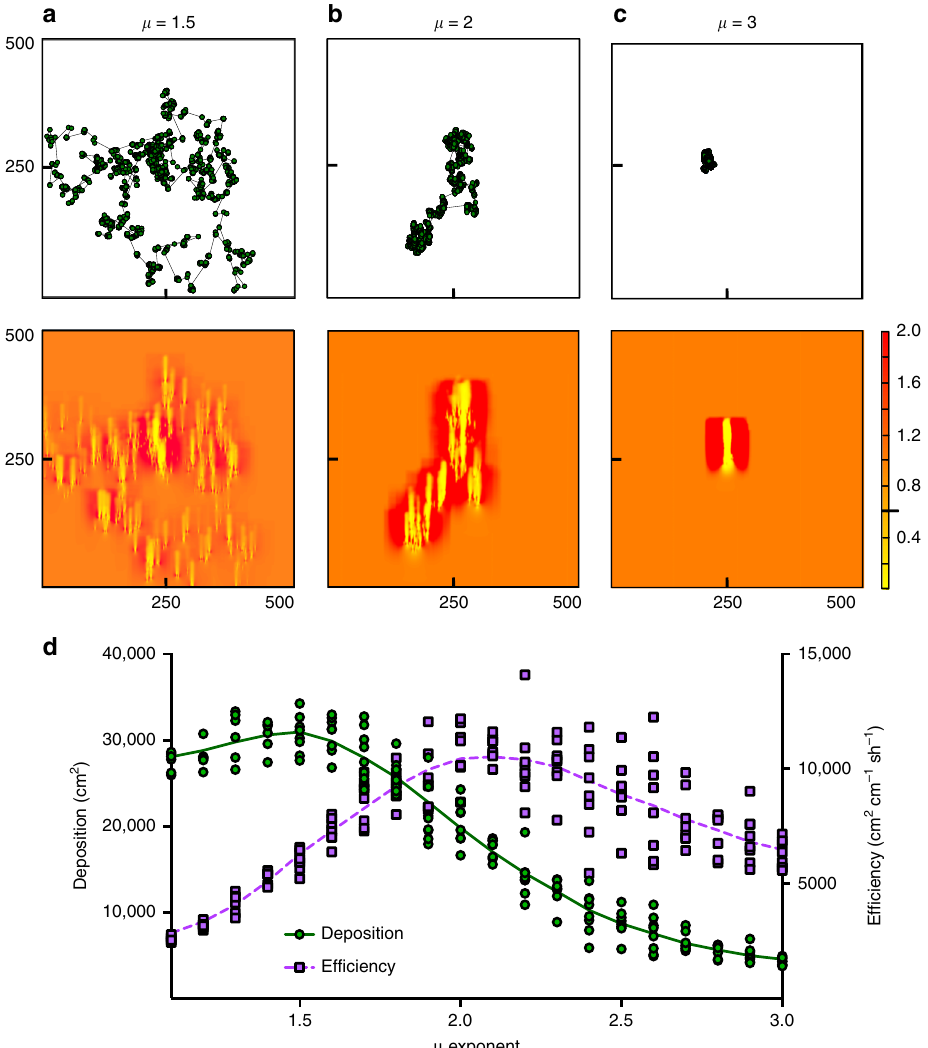
Fig. 3 Effect of clonal expansion strategy on the sand-trapping capacity. a – c Model results showing the effect of the step size distribution (dispersed, μ ~ 1.5; Lévy, μ ~ 2; Brownian, μ ~ 3) on wind speed pro fi les for a clonal network consisting of 4000 shoots ( N = 8, scale on the panel fi gures is in cm). The black indicator on the scale bar at 0.61 indicates the threshold fraction of the wind speed below which sand is deposited. d Sand deposition is highest for the more dispersed strategy and decreases with increased clustering of shoots (green line, left axis). Sand-trapping ef fi ciency, calculated as sand deposition divided by the average rhizome length between shoots, was highest at the Lévy optimum of μ ~2 (dashed purple line, right axis). Error bars represent ± s.e. m. Source data are provided as a Source Data fi